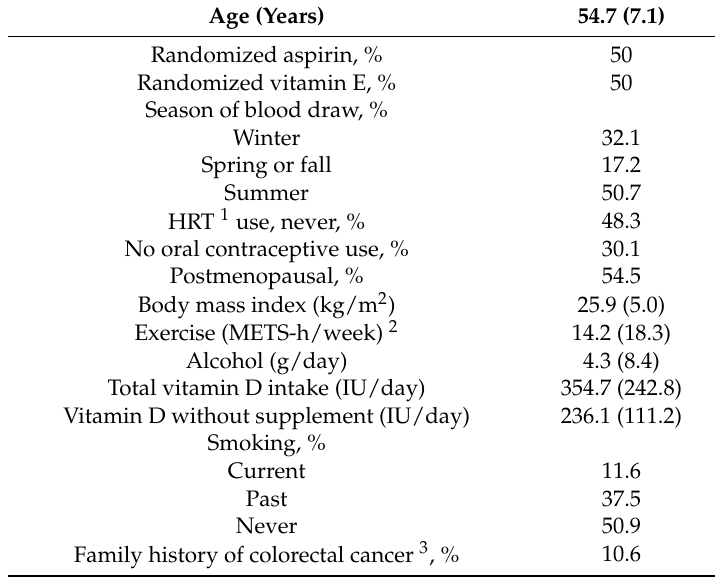
Table 1. Baseline characteristics of Women’s Genome Health Study European ancestry participants ( n = 23,294)